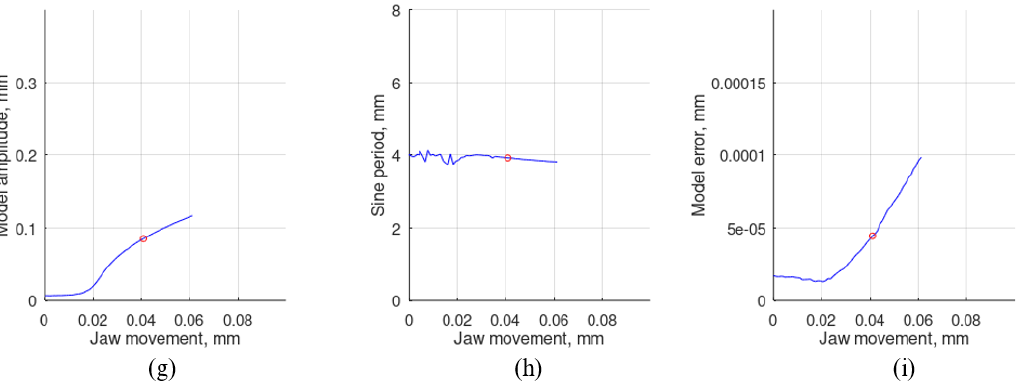
Figure 11. The results of compression analysis of a 4 mm long paper sample after breaking the sample.